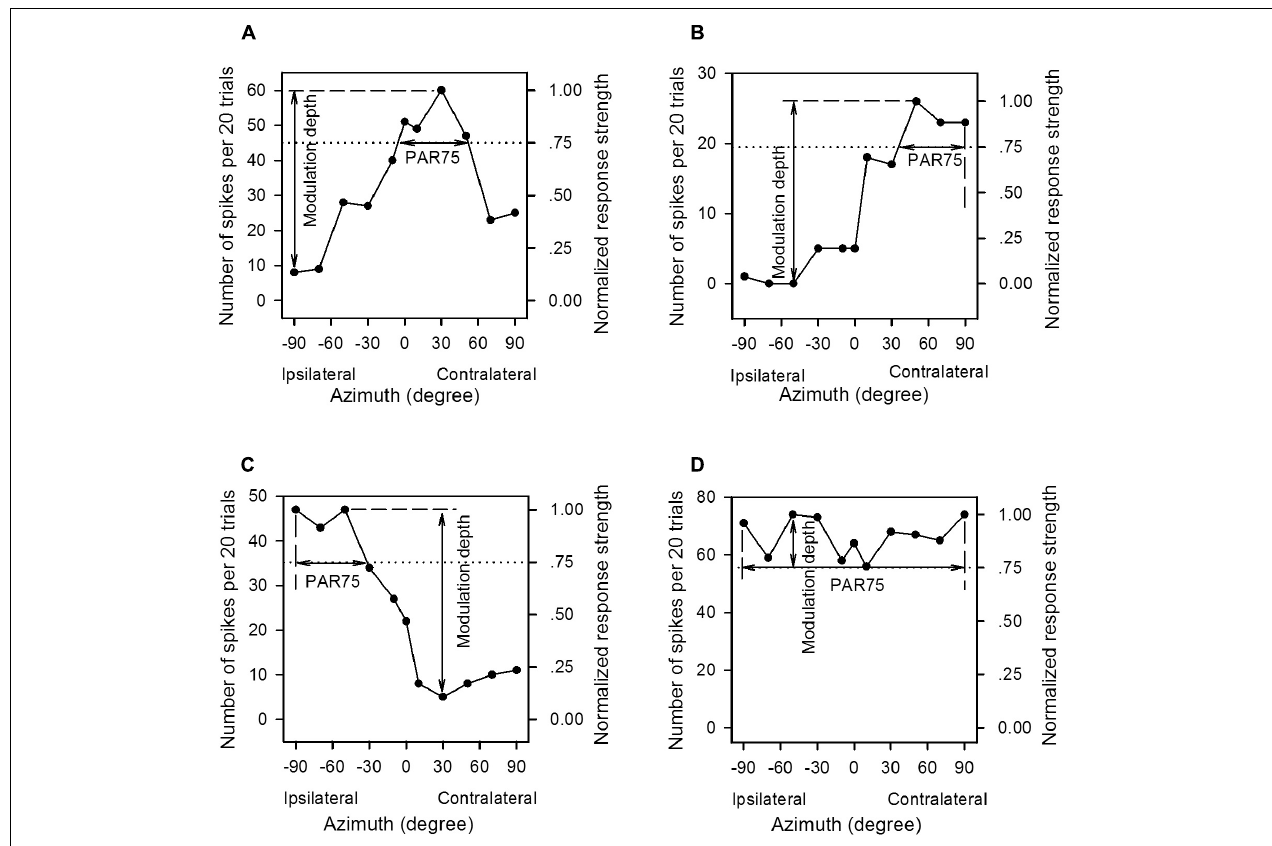
FIGURE 2 | The method to determine the preferred azimuth range and the modulation depth from the azimuth functions of the primary auditory cortex (AI) neurons. (A–D) For each panel, the left y -axis indicates the number of spikes evoked by per 20 trials of tonal stimuli, and the right y -axis indicates the normalized response strength. The spike counts are normalized to the response strengths relative to the maximum spike count in each azimuth function, and the maximum response strength is 1.00. The x -axis indicates the speaker location in degree contralateral (positive azimuth) or ipsilateral (negative azimuth) to the cortex (left cortex) being recorded, and 0 ◦ is midline azimuth. The dotted line indicates 0.75 in normalized response strength. The range of the horizontal solid line with double arrowhead in each panel is defined as the PAR75, i.e., the preferred azimuth range over which the normalized response strengths are ≥ 0.75. The range of the vertical solid line with double arrowhead is defined as the modulation depth, i.e., the difference value between the maximum and the minimum normalized response strength in each azimuth function. See texts in the “Materials and Methods” section for